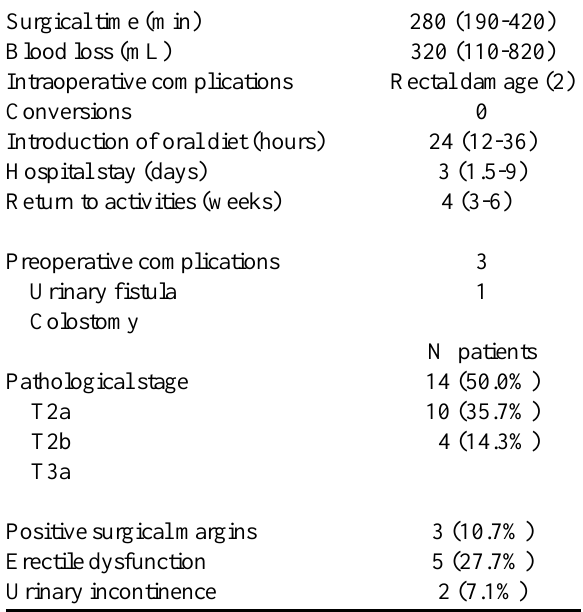
Table 2 – Surgical data from patients undergoing extraperitoneal endoscopic radical prostatectomy with duplication of open